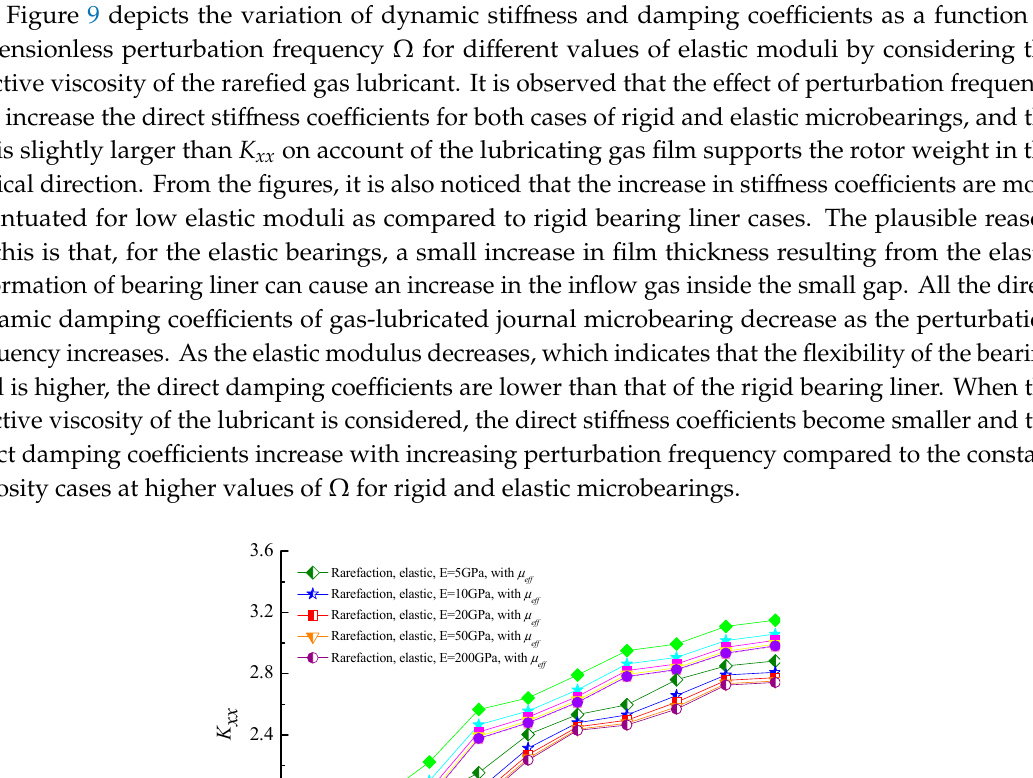
Figure 8. Friction coefficient against the bearing number with effective and constant viscosity for the different elastic moduli of microbearing material ( ε = 0.7, υ = 0.3).